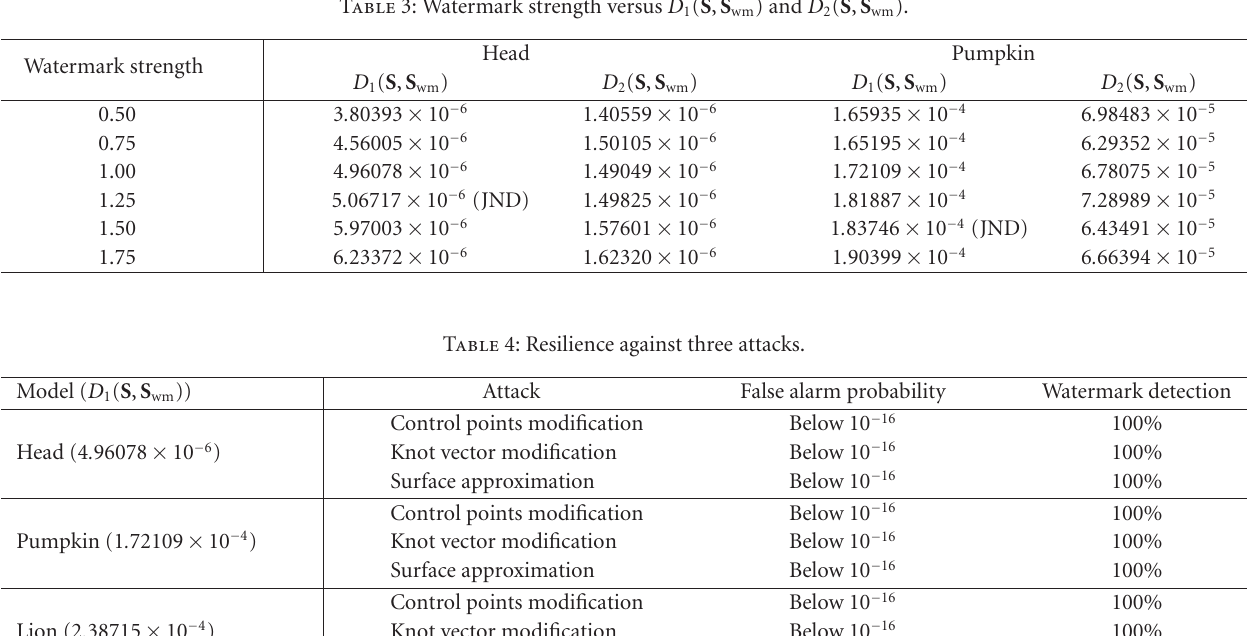
Table 3: Watermark strength versus D 1 ( S , S wm ) and D 2 ( S , S wm ).